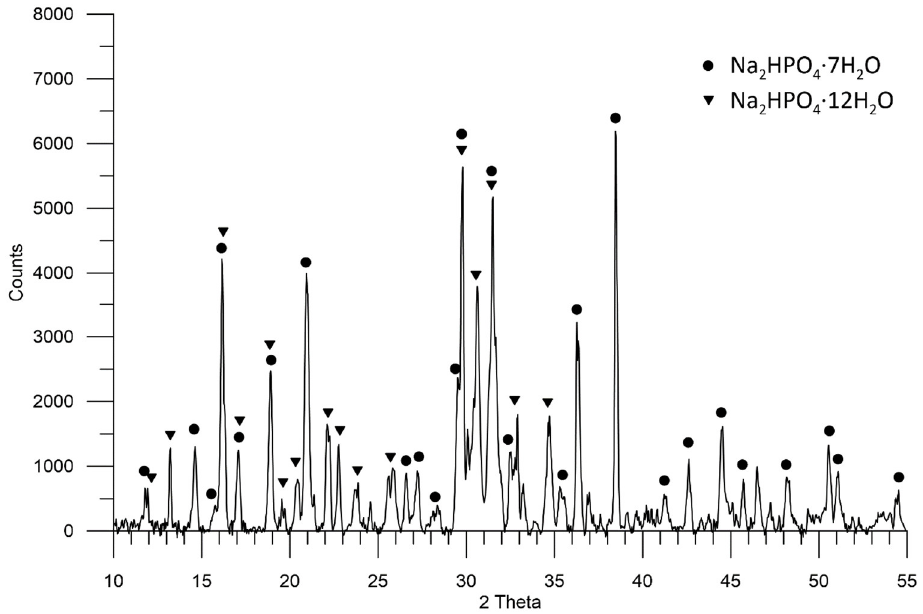
Figure 4. A diffractogram showing the composition of sediment 3 in the sample of waste phosphate from polyol production.